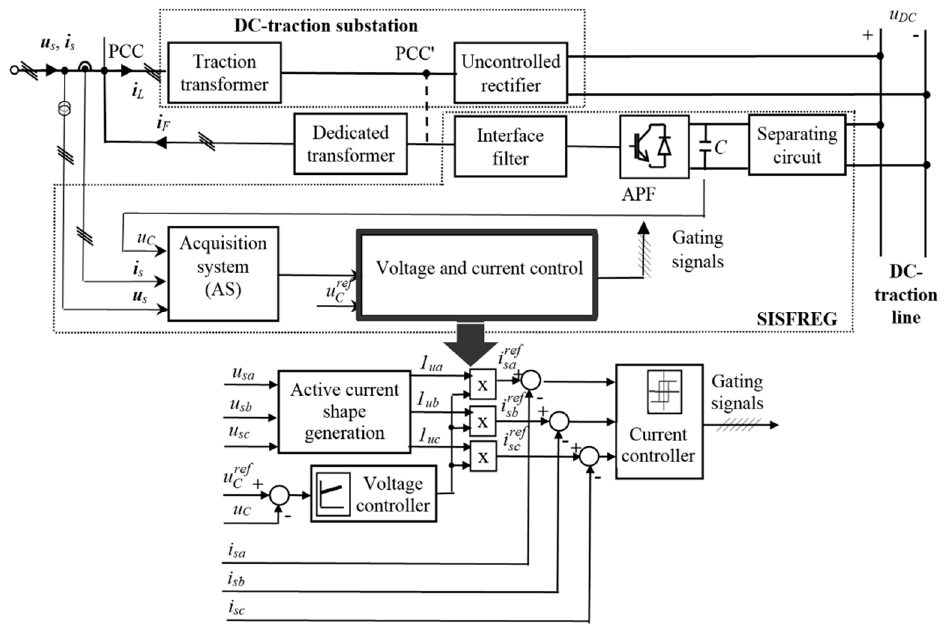
Figure 6. Structure of the indirect control system for SISFREG [103,109].